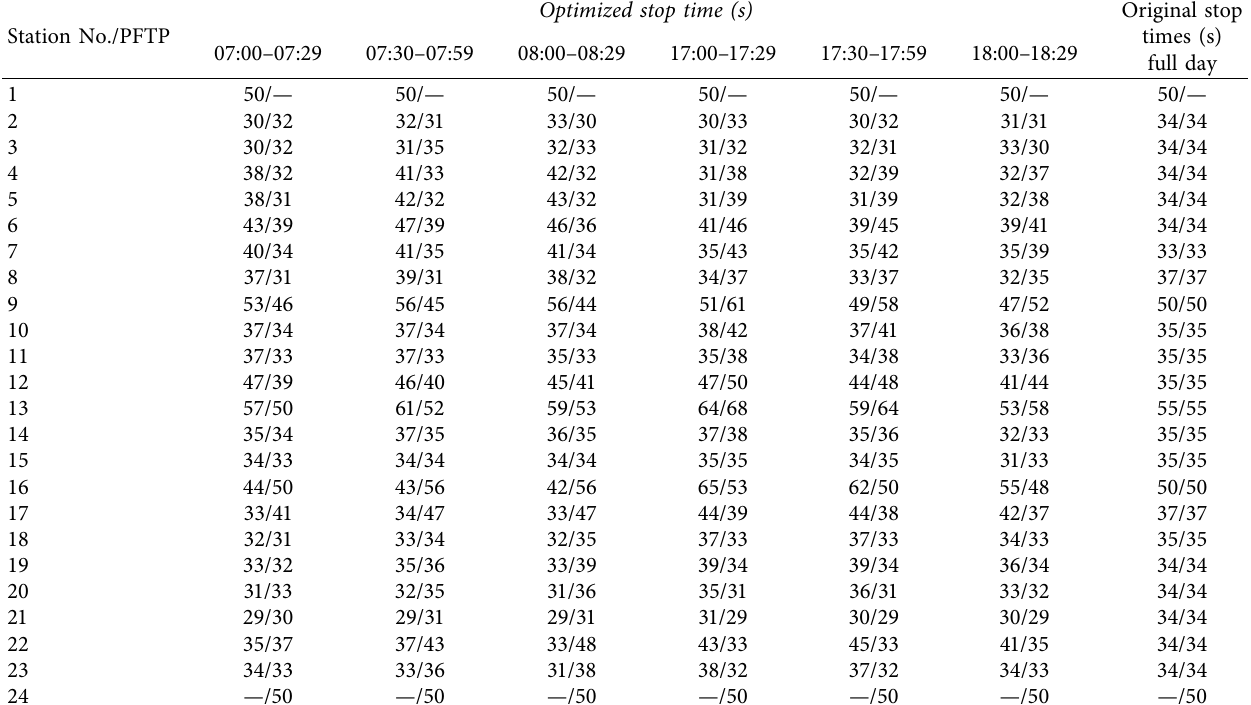
Table 6: Comparison of train stop times.